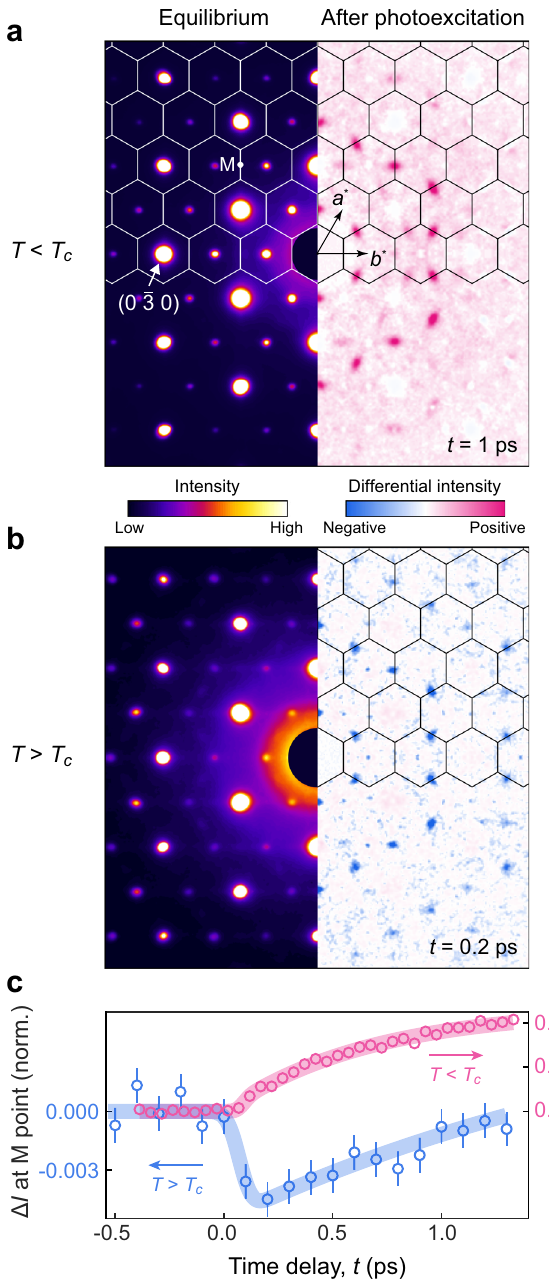
Fig. 3 Distinct photoinduced changes of 2D CDW below and above T c . a , b Left: static electron diffraction patterns along the [0 0 1] zone axis taken at 88 K ( a ) and 295 K ( b ). Hexagons denote the 2D projection of the Brillouin zones. Right: photoinduced change in the diffraction intensity at 1 ps pump-probe delay at 88 K ( a ) and at 0.2 ps delay at 250 K ( b ). The different time delays are chosen to re fl ect the distinct timescales of the intensity change at different temperatures (see panel c ). All diffraction images were symmetrized for enhanced statistics. The equilibrium patterns share the same color scale while that of the differential patterns is individually adjusted to highlight the feature at the M point. See Supplementary Fig. 8 for a side-by-side comparison of differential patterns at two time delays with the same color scale. c Temporal evolutions of intensity change at the M point at 88 K (red) and 250 K (blue). Intensities are normalized to respective pre-excitation values. Error bars, if larger than the marker size, represent the standard deviation of intensity values prior to excitation. The incident fl uence for all panels is 560 μ J/cm 2